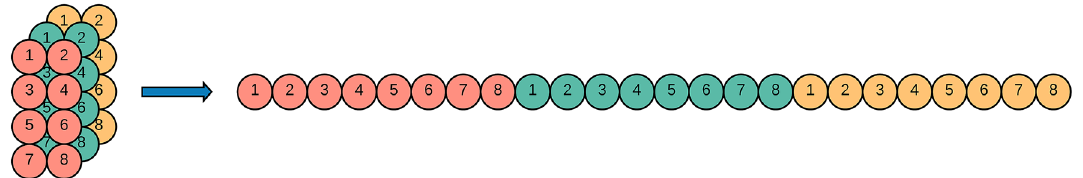
Figure 1. Example of a 3D-image of size 4